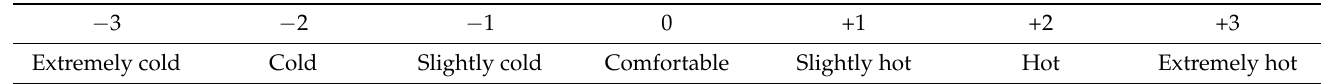
Table 1. Scale of PTS